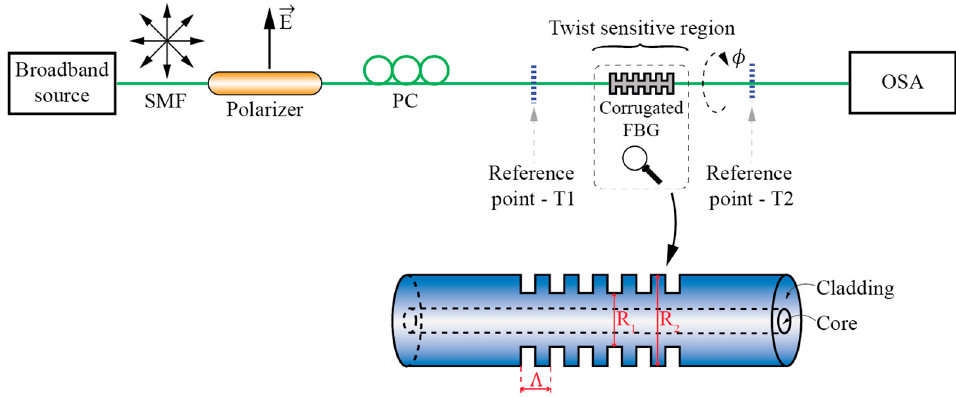
Figure 9. Corrugated LPFBG twist/torsion test setup